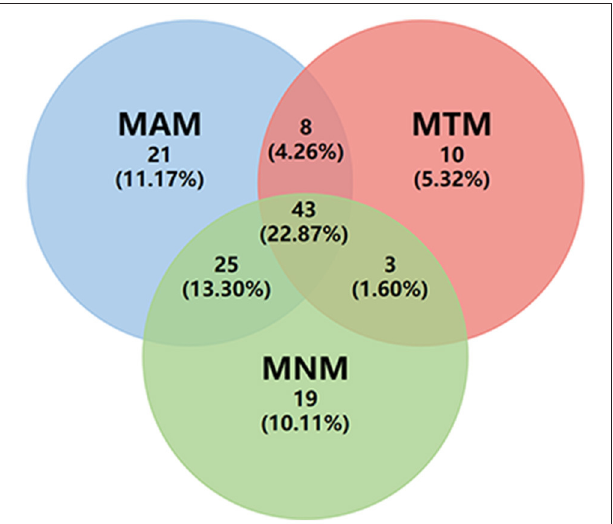
FIGURE 2 | Venn diagram of eye count in three different types of myopic maculopathy. MAM, myopic atrophic maculopathy; MTM, myopic tractional maculopathy; MNM, myopic neovascular